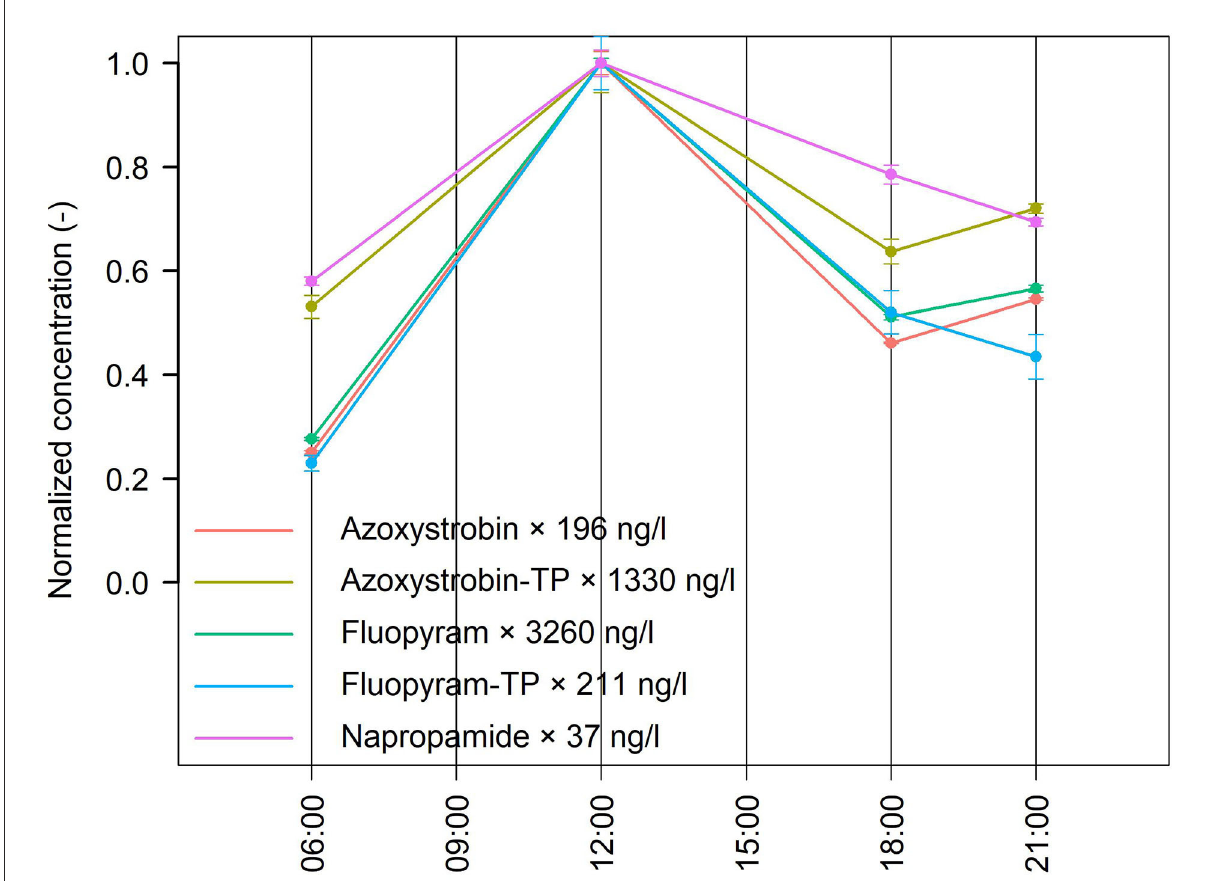
FIGURE7 Time series of normalized concentration values for selected compounds measured during the dry-day campaign on August 12 th 2020 at the upstream right location ES2. Concentration values normalized by the daily maximum concentration of the corresponding compound. Vertical bars indicated the standard deviation of the three injections per sample divided by the daily maximum concentration of the corresponding